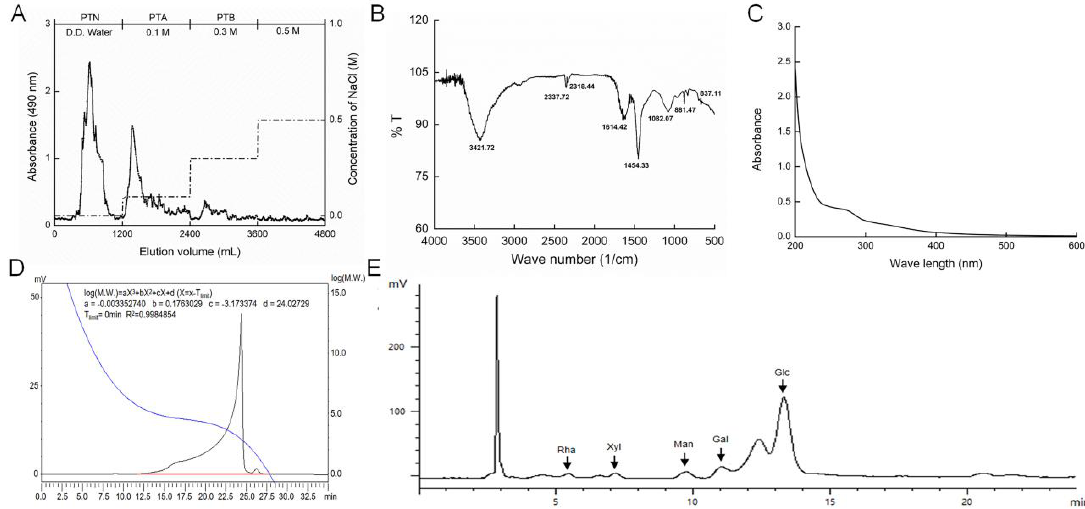
Figure 1. Purification and characterization of polysaccharides from Termitornyces albuminosus (PTA). ( A ) Crude polysaccharides were isolated using diethylethanolamine-52 (DEAE-52), and PTA was obtained by elution using 0.1 M NaCl. ( B ) Fourier transform infrared spectroscopy spectrum of PTA. ( C ) UV spectrum of PTA. ( D ) Molecular weight analysis using a high performance liquid chromatography (HPLC) system equipped with a TSK-GEL G4000PWXL column. ( E ) Analysis of monosaccharides composition after acid hydrolyzing of PTA with a HPLC system.